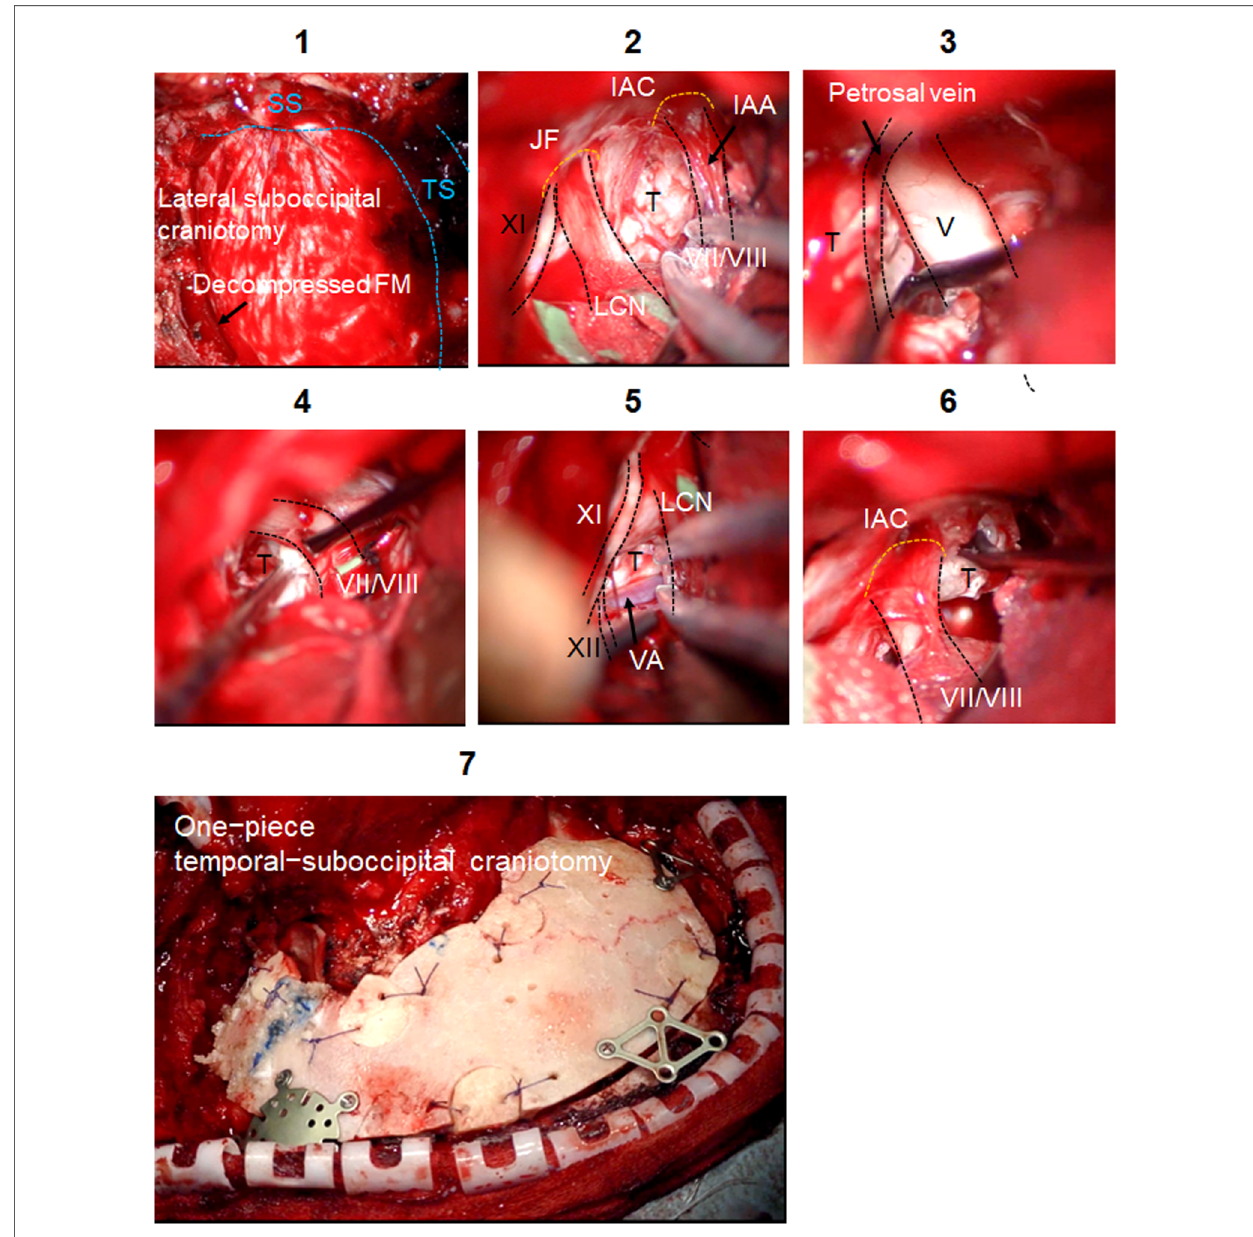
FIGURE 3 Intraoperative fi ndings of the LSO. Microsurgical maneuvers of the LSO are shown. Surgical fi eld of the LSO is shown. SS is skeletonized. Foramen magnum decompression is performed (1). The dura is incised in a C-shape fashion, and the cerebellar hemisphere is gently retracted to expose the cerebellomedullary cistern (2). Tumor removal around the trigeminal nerve (3), facial/vestibulocochlear nerves (4), and LCN (5) is done. Tumors growing below vertebral artery (VA) and hypoglossal nerve are removed (5). Tumor extending into the IAC is gently removed with curette (6). The decompression is achieved by removing bone posterior and inferior to the IAC. The one-piece temporal-suboccipital bone fl ap is replaced and attached to the surrounding bone with titanium plates and screws (7). IAC, internal auditory canal; FM, foramen magnum; IAA, internal auditory artery; JF, jugular foramen; LCN, lower cranial nerves; T, tumor; TS, transverse sinus; SS, sigmoid